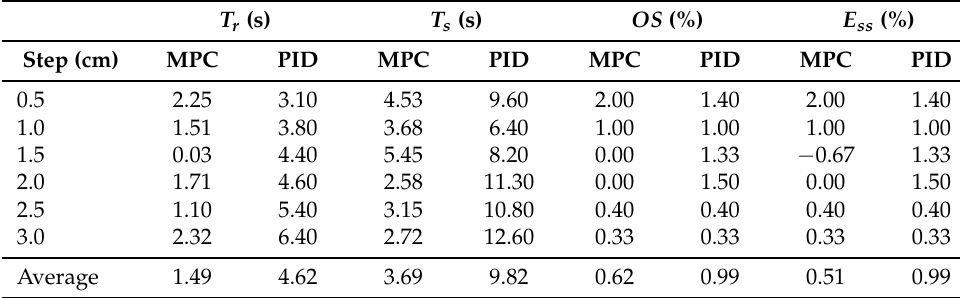
Figure 11. Result of SMPC versus GSPID setpoint tracking experiments. Table 4. Comparison between SMPC and GSPID setpoint tracking